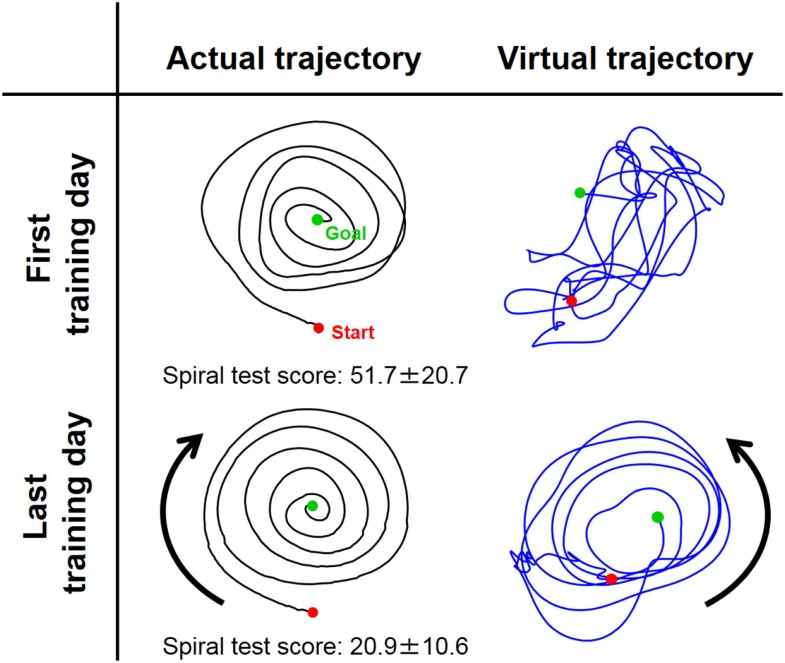
Typical change in virtual trajectory from the first and last days of voluntary training (Subject #1). The change in the virtual trajectories (blue) was extreme compared to that for the actual trajectories (black). The virtual trajectories were organized from disordered patterns into well-regulated but slightly distorted spiral patterns that rotated in the opposite direction of the actual trajectory. The score of the spiral test decreased correspondingly from 51.7 ± 20.7 to 20.9 ± 10.6, indicating that motor performance was improved in terms of speed and accuracy.